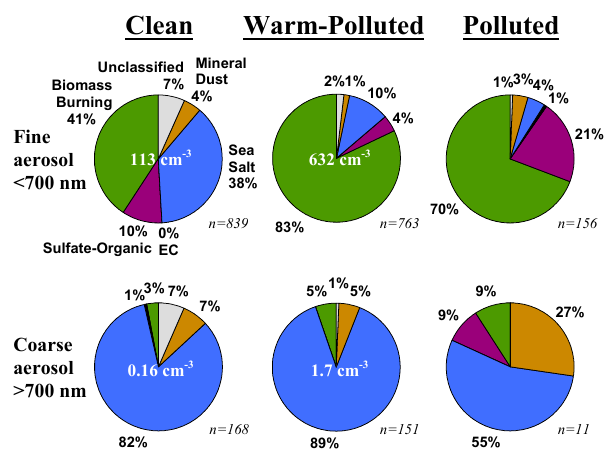
Fig. 3. Fraction of fine and coarse aerosol particle types identified by single particle mass spectrometry. Number concentrations in- ferred from the coarse aerosol size distributions are listed in white text. Also reported are the number of particles detected by the PALMS for each case ( n